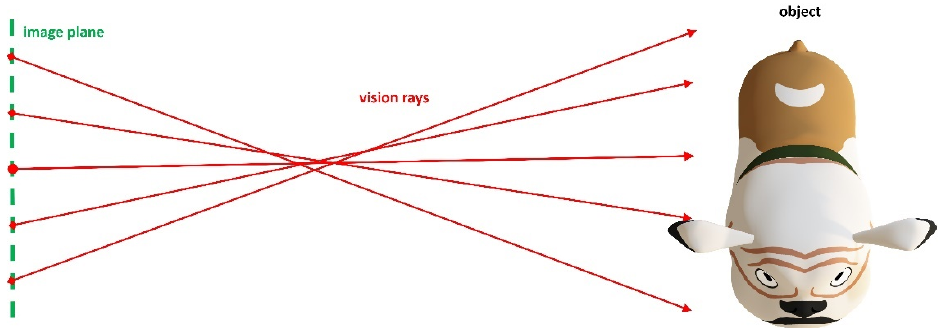
Figure 2. Ray ‐ based ‐ camera model. Rays do not necessarily intersect. Figure 2. Ray-based-camera model. Rays do not necessarily